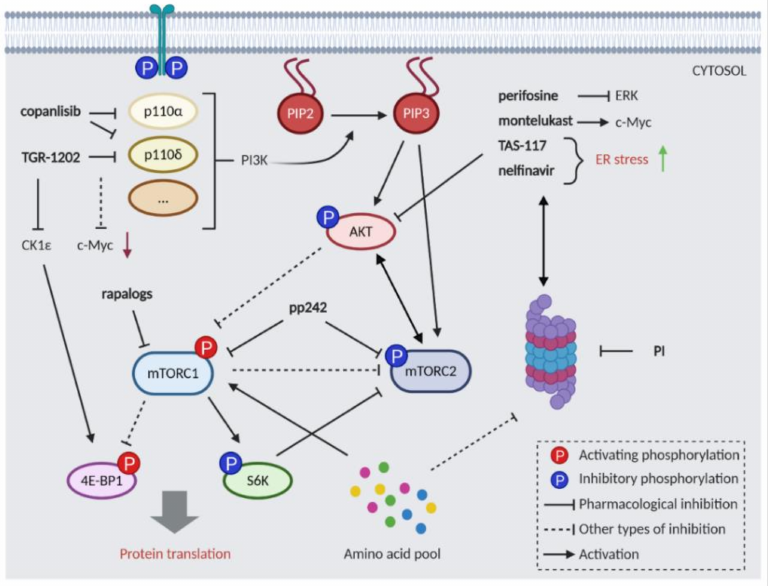
Figure 2. Inhibition of proteasome inhibitor (PI) and PI3K/AKT/mTOR pathway results in syn- ergistic cellular death. The PI3K/AKT/mTOR pathway is a central signaling hub in eukaryotic cells and it is connected to the ubiquitin–proteasome system (UPS) by balancing amino acid home- ostasis (amino acid pool). Intensive feedback loops between mTORC1, mTORC2, and AKT pose a challenge to the successful inhibition of this pathway. Rapalogs target the mTORC1 complex; the mTORC1/mTORC2 dual inhibitor pp242 (torkinib) is more effective in combination with PI. The PI3K inhibitors copanlisib and TGR-1202 demonstrated synergistic cytotoxicity with PI. Several AKT inhibitors (perifosine, TAS-117, nelfinavir, montelukast) were found to synergize with (PI) by affecting endoplasmic reticulum (ER) stress, ERK, or